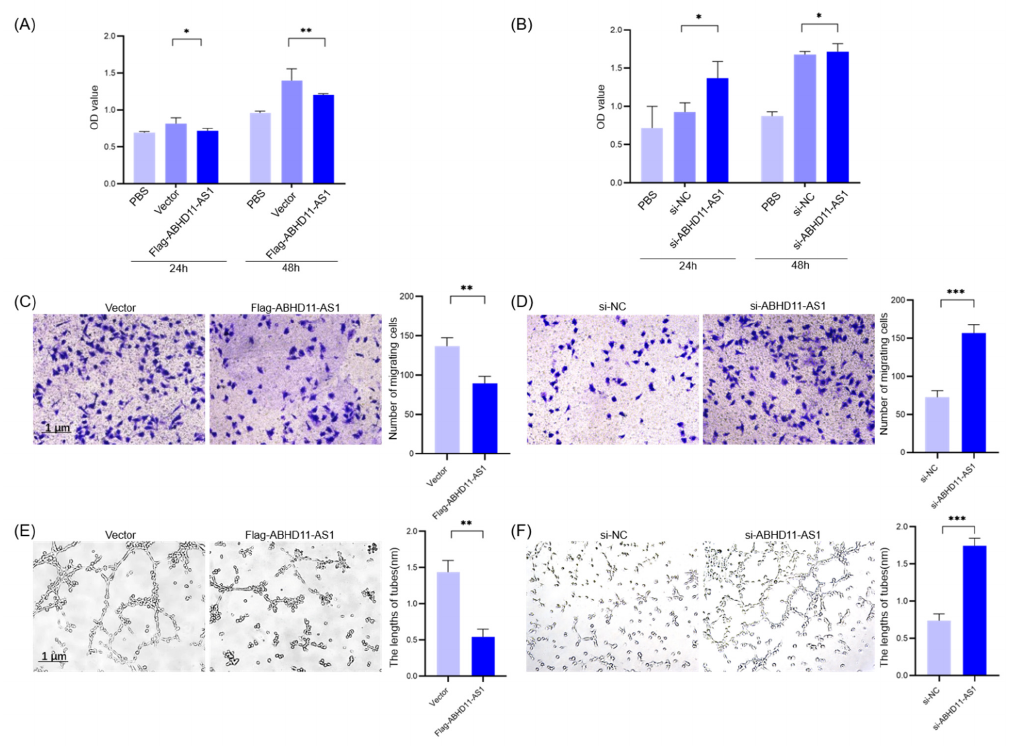
Figure 5. ABHD11-AS1 suppresses the proliferation, migration, and tube-forming ability of HLECs. ABHD11-AS1 was overexpressed or interfered with in the HLECs, and the proliferation and tube- formation of HLECs were tested. ( A ) CCK8 assay was performed to observe the viability of cells after overexpressing with ABHD11-AS1 ( n = 3). ( B ) Viability of cells after interfering with ABHD11-AS1 was detected ( n = 3). ( C ) Transwell assay was performed to detect the migration of HLECs after overexpressing with ABHD11-AS1 ( n = 3). ( D ) After interfering with ABHD11-AS1, the migration of cells was tested ( n = 3). ( E ) Tube-formation assay was performed to test the tube-forming ability of HLECs after overexpressing with ABHD11-AS1 ( n = 3). ( F ) After interfering with ABHD11-AS1, the tube-forming ability of HLECs was tested ( n = 3). * p < 0.05. ** p < 0.01, *** p < 0.001.